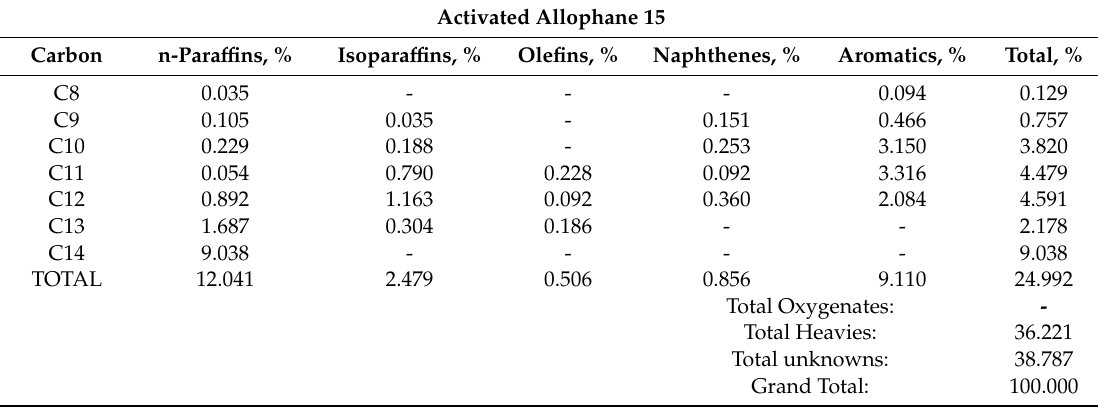
Table 26. Total composition results by group type and carbon number, as a percentage of the mass of activated allophane